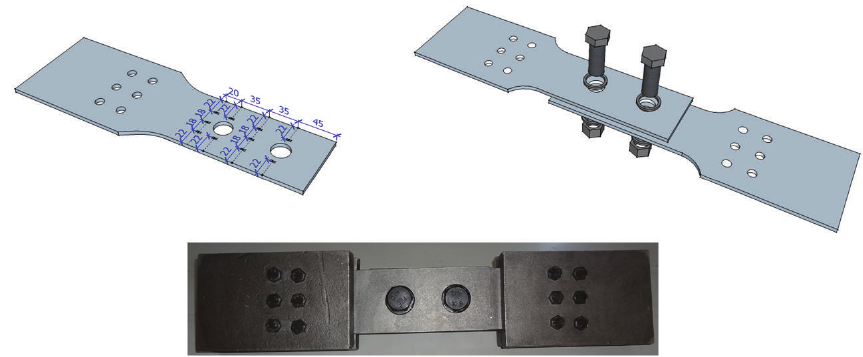
Figure 1: Schematic of specimens and the assembling, dimensions in